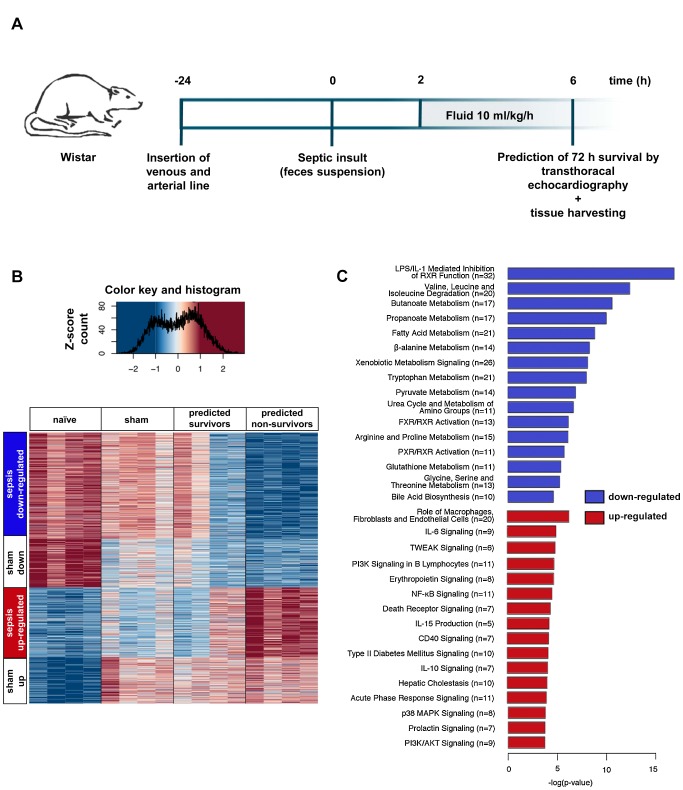
Rat model allowing assessment of early changes in gene expression, and relationships to outcome.(A) Protocol for instrumentation, induction of sepsis, echo-guided prognosis stratification, and tissue harvesting. (B) The heatmap displays expression profiles of 1,373 genes with significantly different expression levels among the naïve, sham, predicted sepsis survivor, and predicted non-survivor groups (n = 4 per group). k-Means clustering revealed four gene clusters with comparable behaviour. Associated colours represent variance-normalised expression for individual genes: red colour intensity indicates a relative expression greater than the mean, blue indicates the opposite. (C) The transcripts identified in (B) were analysed by Ingenuity Pathway Analysis to identify canonical pathways found to be up- or down-regulated in animals predicted to die. Presented is a bar chart of the most statistically significant (corresponding to p-value) down-regulated (blue) and up-regulated (red) pathways associated with poor prognosis. Numbers in parentheses represent the number of differentially regulated transcripts involved in a defined pathway.